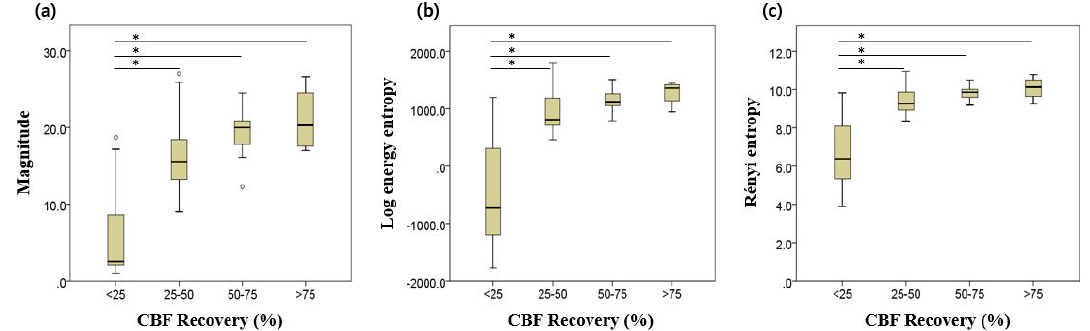
Figure 5. Results of one-way ANOVA: ( a ) magnitude; ( b ) log energy entropy; ( c ) R é nyi entropy. Asterisk (*) denotes statistical significance at the p < 0.001 level. Error bars indicate the upper and lower extreme values of the data. Table 3. Results of multiple comparisons between groups in three EEG parameters .